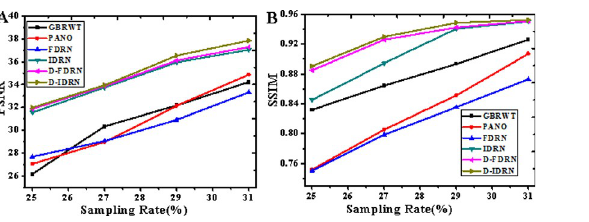
Fig 4. Quality analysis on reconstructed images under different sampling rates. Note: Fig 4A and 4B illustrated the comparisons of PSNR and SSIM of the reconstructed image under different sampling rates, respectively.